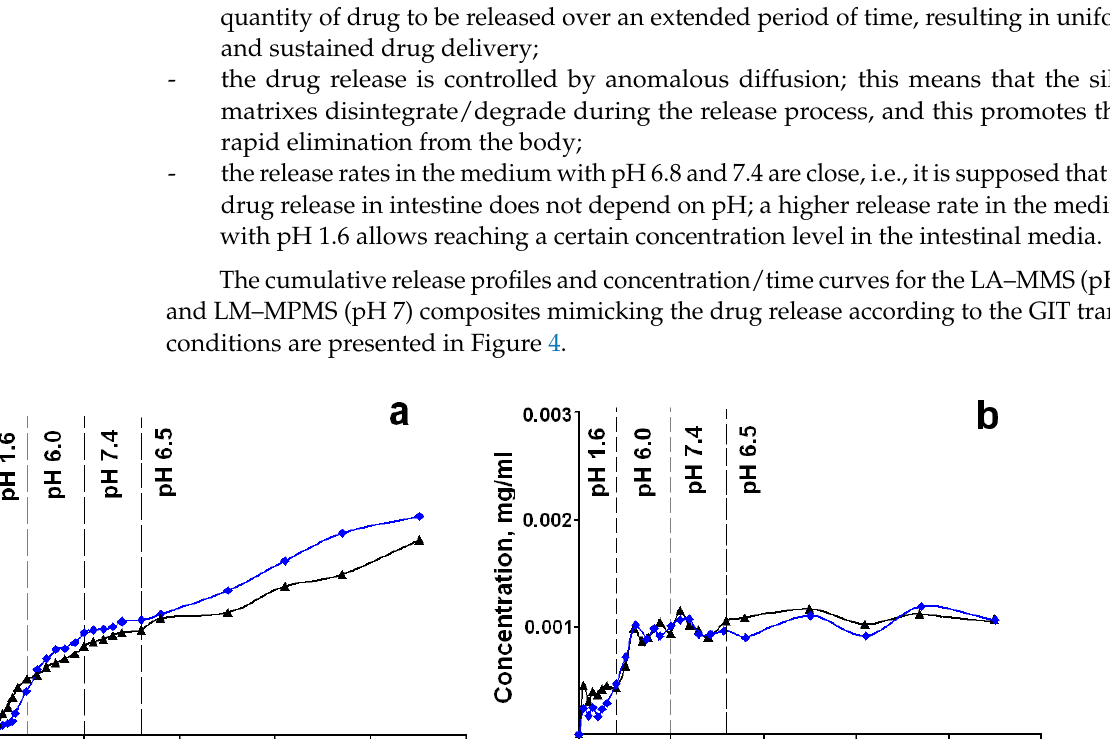
Table 5. Model parameters of LA and LM release from LA–MMS (pH 7) and LM–MPMS (pH 7) composites taking into account the conditions of transit through the GIT.